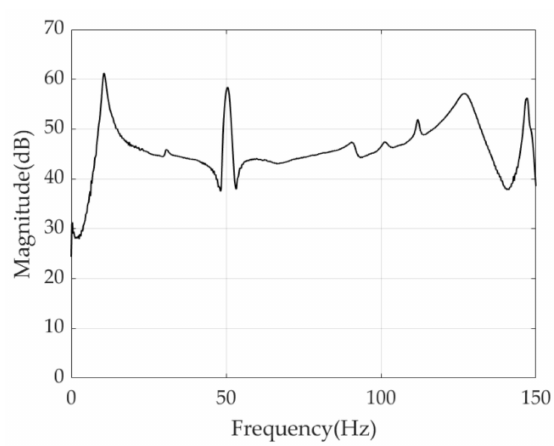
Figure 3. Frequency response function of the target